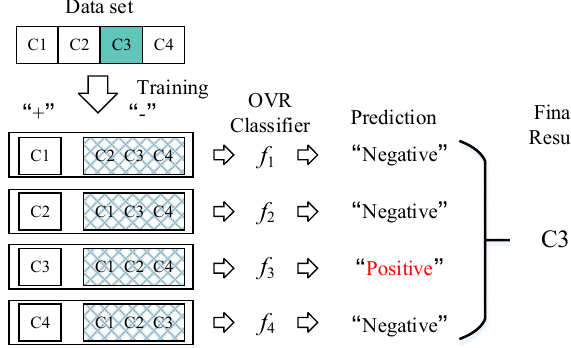
Figure 3. The diagram of the “one-versus-rest” (OVR) multiclass strategy.